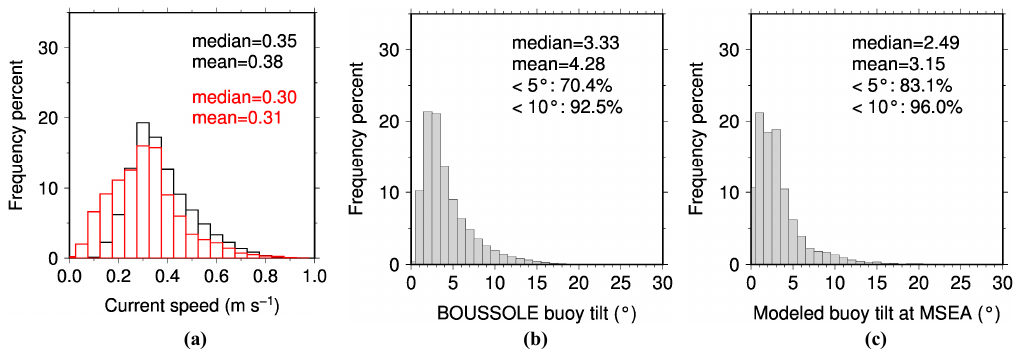
Figure 17. Distribution of ( a ) the current speed at BOUSSOLE (modelled; black) and MSEA (measured; red), the modelled buoy tilt at ( b ) BOUSSOLE, and ( c ) MSEA with the improved buoy design.